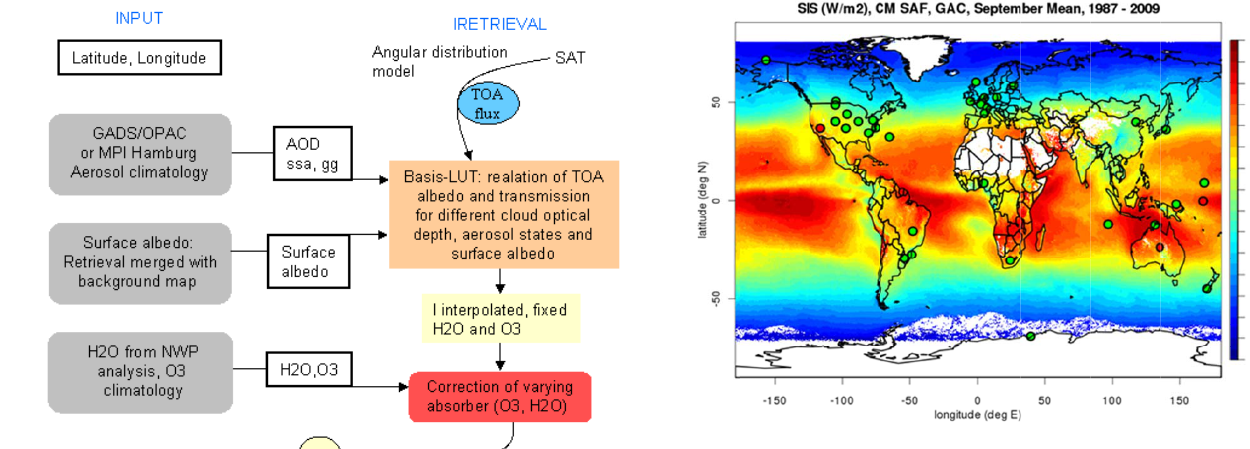
Fig. 10. Multi-year average of the CLARA-A1 surface solar irra- diance [W m − 2 ] dataset for the month of September and valida- tion results obtained by comparison with available BSRN surface measurements. Green dots represent surface stations where the SIS dataset is within the target accuracy of 10 W m − 2 for monthly means; red dots correspond to surface stations where the SIS dataset does not meet the target accuracy.